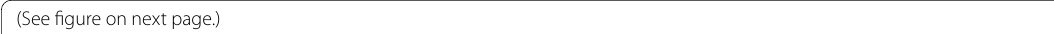
Fig. 5 Input data of the proposed method: a sketch of the operative grid with TCUs over the study area; b inventory map of the slow-moving landslides (SMLs) distinguished according to their state of activity (active and dormant); c geo-lithological setting with lithological units (LU) grouped in four classes: LU1 (coarse-grained soils, i.e. sands, sandstones, gravels, conglomerates), LU2 (carbonate rocks, i.e. limestone and dolomites), LU3 (crystalline-metamorphic rocks, i.e. phyllite, schist, gneiss, and granitoids), LU4 (fine-grained soils, i.e. silt, clay, marl); d map of average slope angles (S) distinguished in four classes: